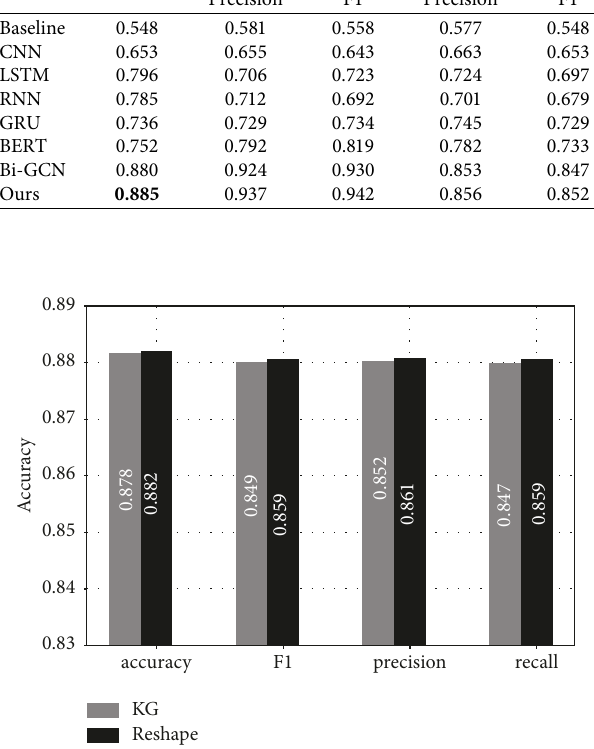
Figure 8: Schematic diagram of comparative analysis of knowledge graph and reshaped dependency tree. Table 5: GAT results based on two different parsers, unlabeled attachment score, and labeled attachment score are indicators for evaluating parsers. The higher the score, the better the performance.